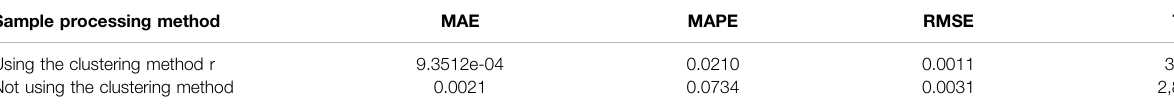
TABLE 4 | Comparison of using the NGC clustering processing method.